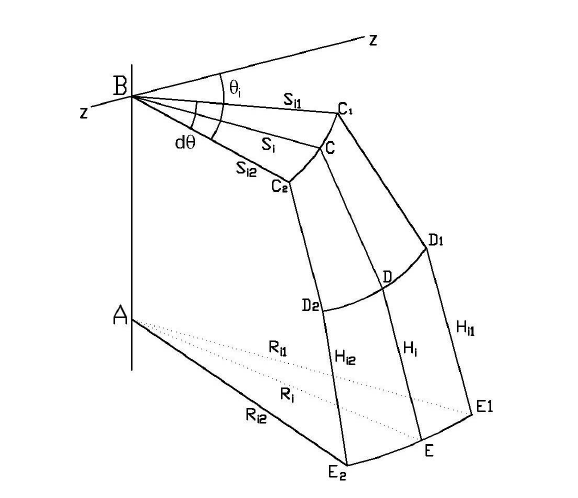
Fig. 5. Geometry of Single Element (i th